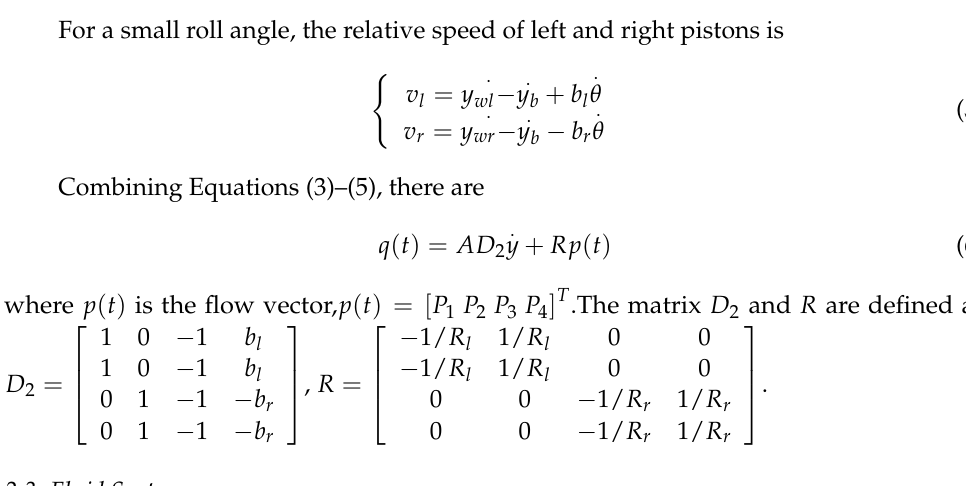
Figure 3. The mechanical–fluid system boundary